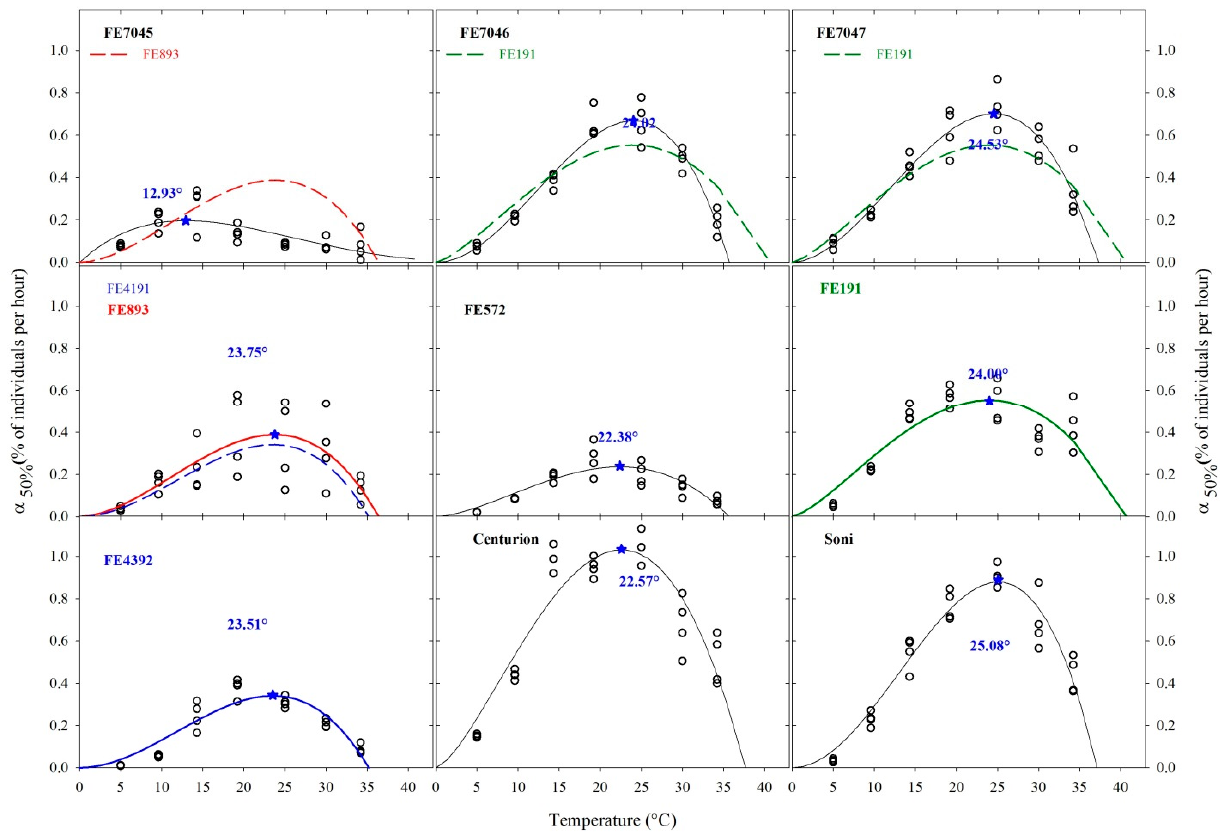
Figure 4. Estimated germination rates when 50% of the seeds have germinated ( α 50% ) fitted with the Beta model for nine accessions of F. arundinacea in response to a constant temperature. Estimated optimal temperature is indicated by (cid:70)